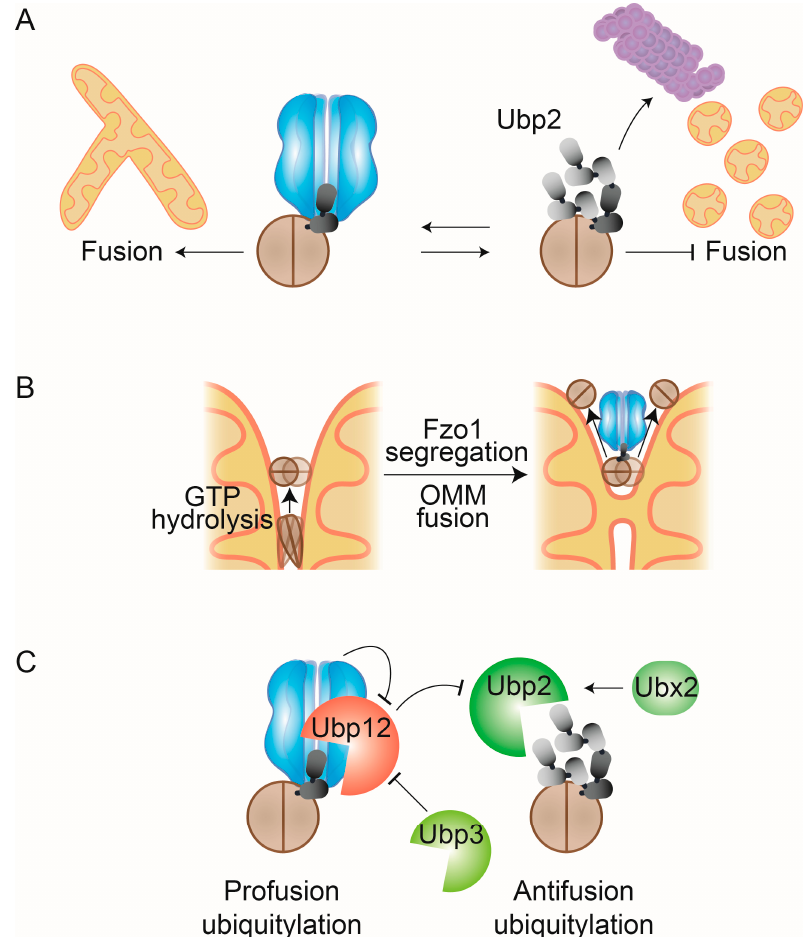
Figure 5. Regulation of OMM fusion by Cdc48. ( A ) After GTP hydrolysis, Fzo1 is modified by short ubiquitin chains that are recognized by Cdc48 and that promote mitochondrial fusion. Further ubiquitylation of Fzo1creates a degradation signal that instead targets Fzo1 for degradation by the proteasome, thereby inhibiting fusion. ( B ) Cdc48 enables Fzo1-dependent membrane merging. OMM merging requires relocalization of mitofusins away from the site of membrane merging, likely mediated by conformational changes of Fzo1, dependent on GTP-hydrolysis. After GTP- hydrolysis Fzo1 can be ubiquitylated and recognized by Cdc48. This leads to complex segregation, allowing OMM fusion and recycling of Fzo1. ( C ) Cdc48-dependent DUB cascade. Profusion ubiquitylated Fzo1 forms are cleaved by the DUB Ubp12, while antifusion forms, which are built on previously attached regulatory forms, are cleaved by the DUB Ubp2. Cdc48 inhibits Ubp12 activity, while Ubp12 inhibits Ubp2 activity. Thereby, Cdc48 promotes fusion by firstly inhibiting cleavage of profusion ubiquitin forms on Fzo1 and secondly by promoting cleavage of proteolytic ubiquitin forms on Fzo1. Furthermore, Ubp12 is negatively regulated by the DUB Ubp3 while Ubp2 is stabilized by